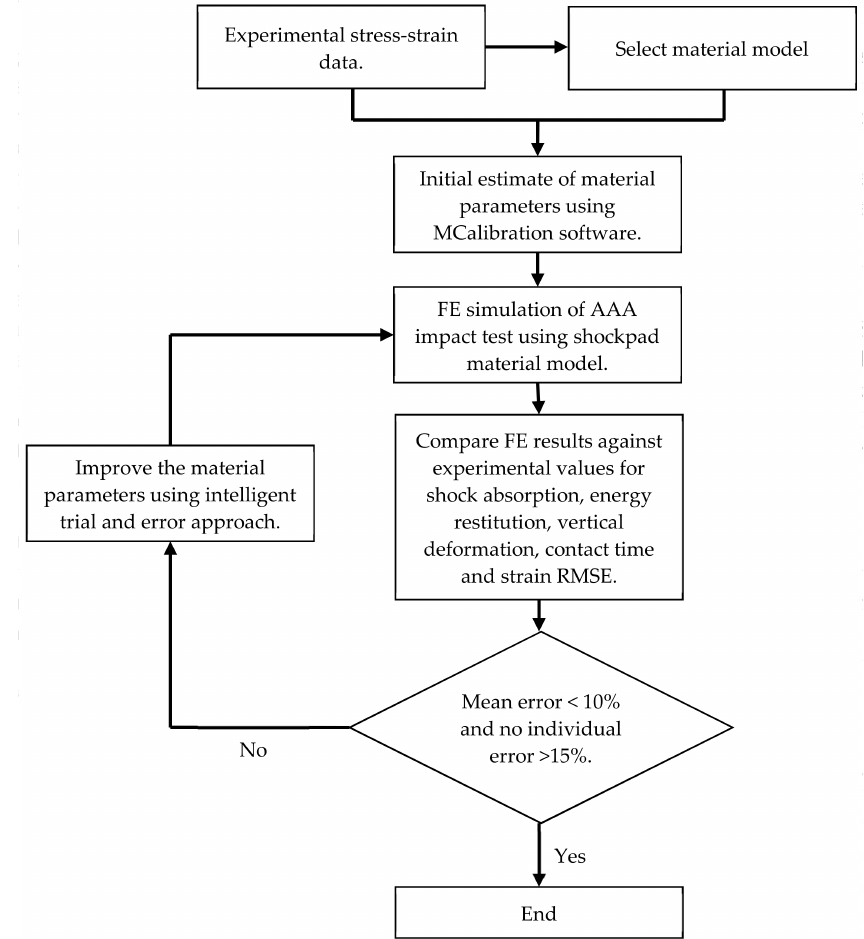
Figure 7. Flow chart showing the steps involved in material model